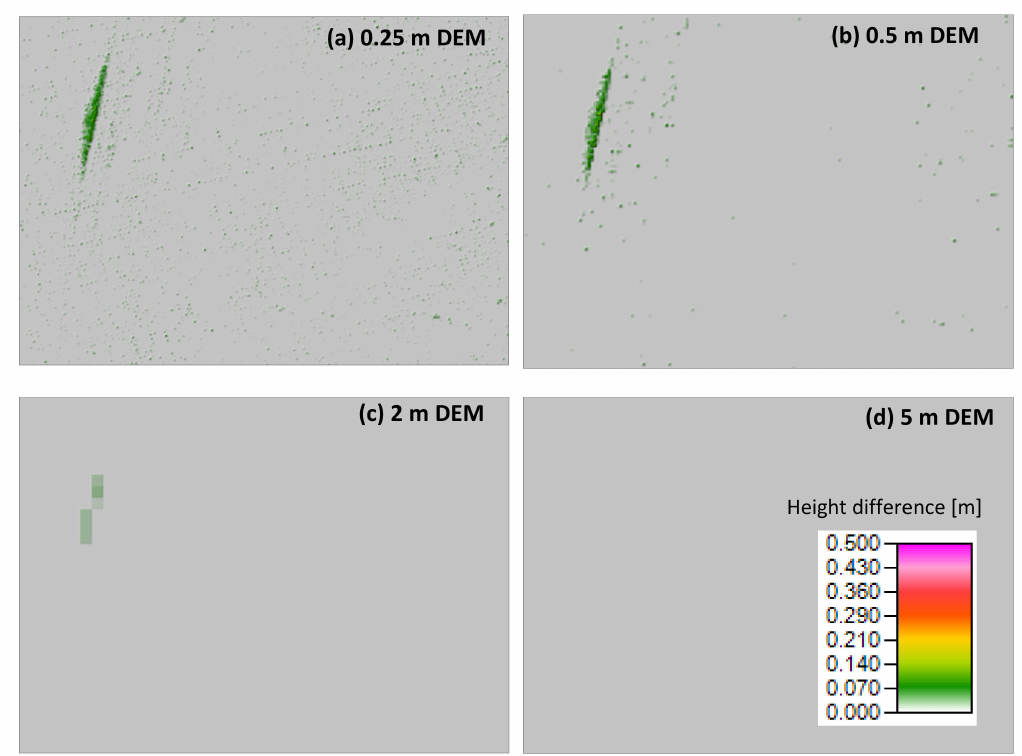
Figure 20. Identified sinks for DEM with ( a ): 0.25 m, ( b ): 0.5 m, ( c ): 2 m and ( d ): 5 m spatial